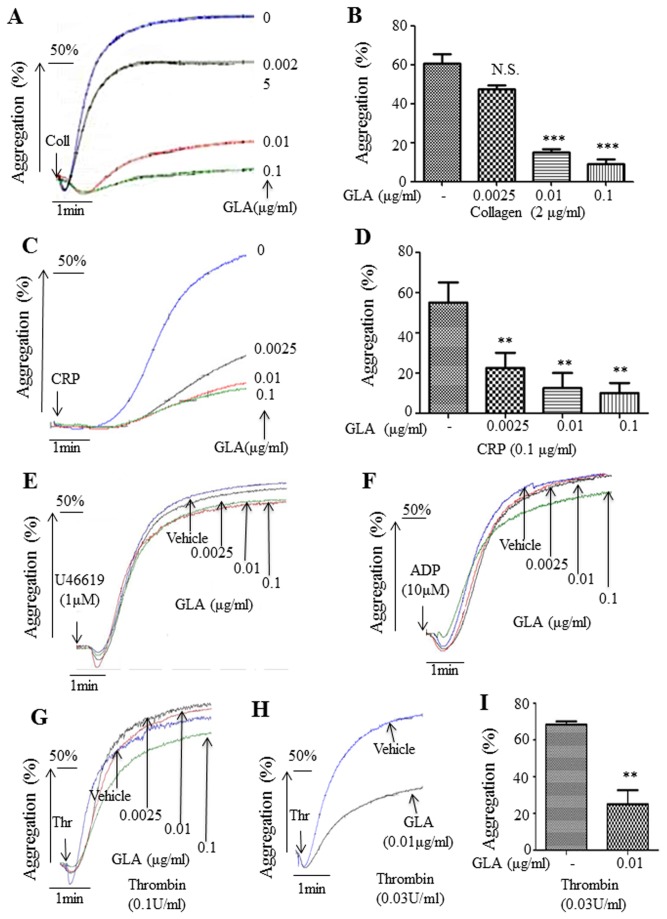
Effects of GLA on agonist-induced platelet aggregation.Gel-filtered platelets (2.5×108/ml) were pre-incubated for 10 min with different concentrations of GLA (0.0025, 0.01, and 0.1μg/mL) or vehicle (DMSO). Platelet aggregation was initiated with collagen (2μg/ml) (A), CRP (0.1μg/ml) (C), U46619 (1μmol/L) (E), ADP (10μmol/L) (F), and thrombin of both a high dose (0.1U/ml) (G) and a low dose (0.03U/ml) (H). Maximum extent of platelet aggregation from three individual experiments was plotted in the bar charts (mean ± standard error, n=3). The statistical significance was determined by one-way ANOVA analysis of variance with the Bonferroni post test (B, D, and I). **P<0.01. ***P<0.001. N.S., not significant compared to vehicle control. E, F, and G are representatives of at least three individual experiments.